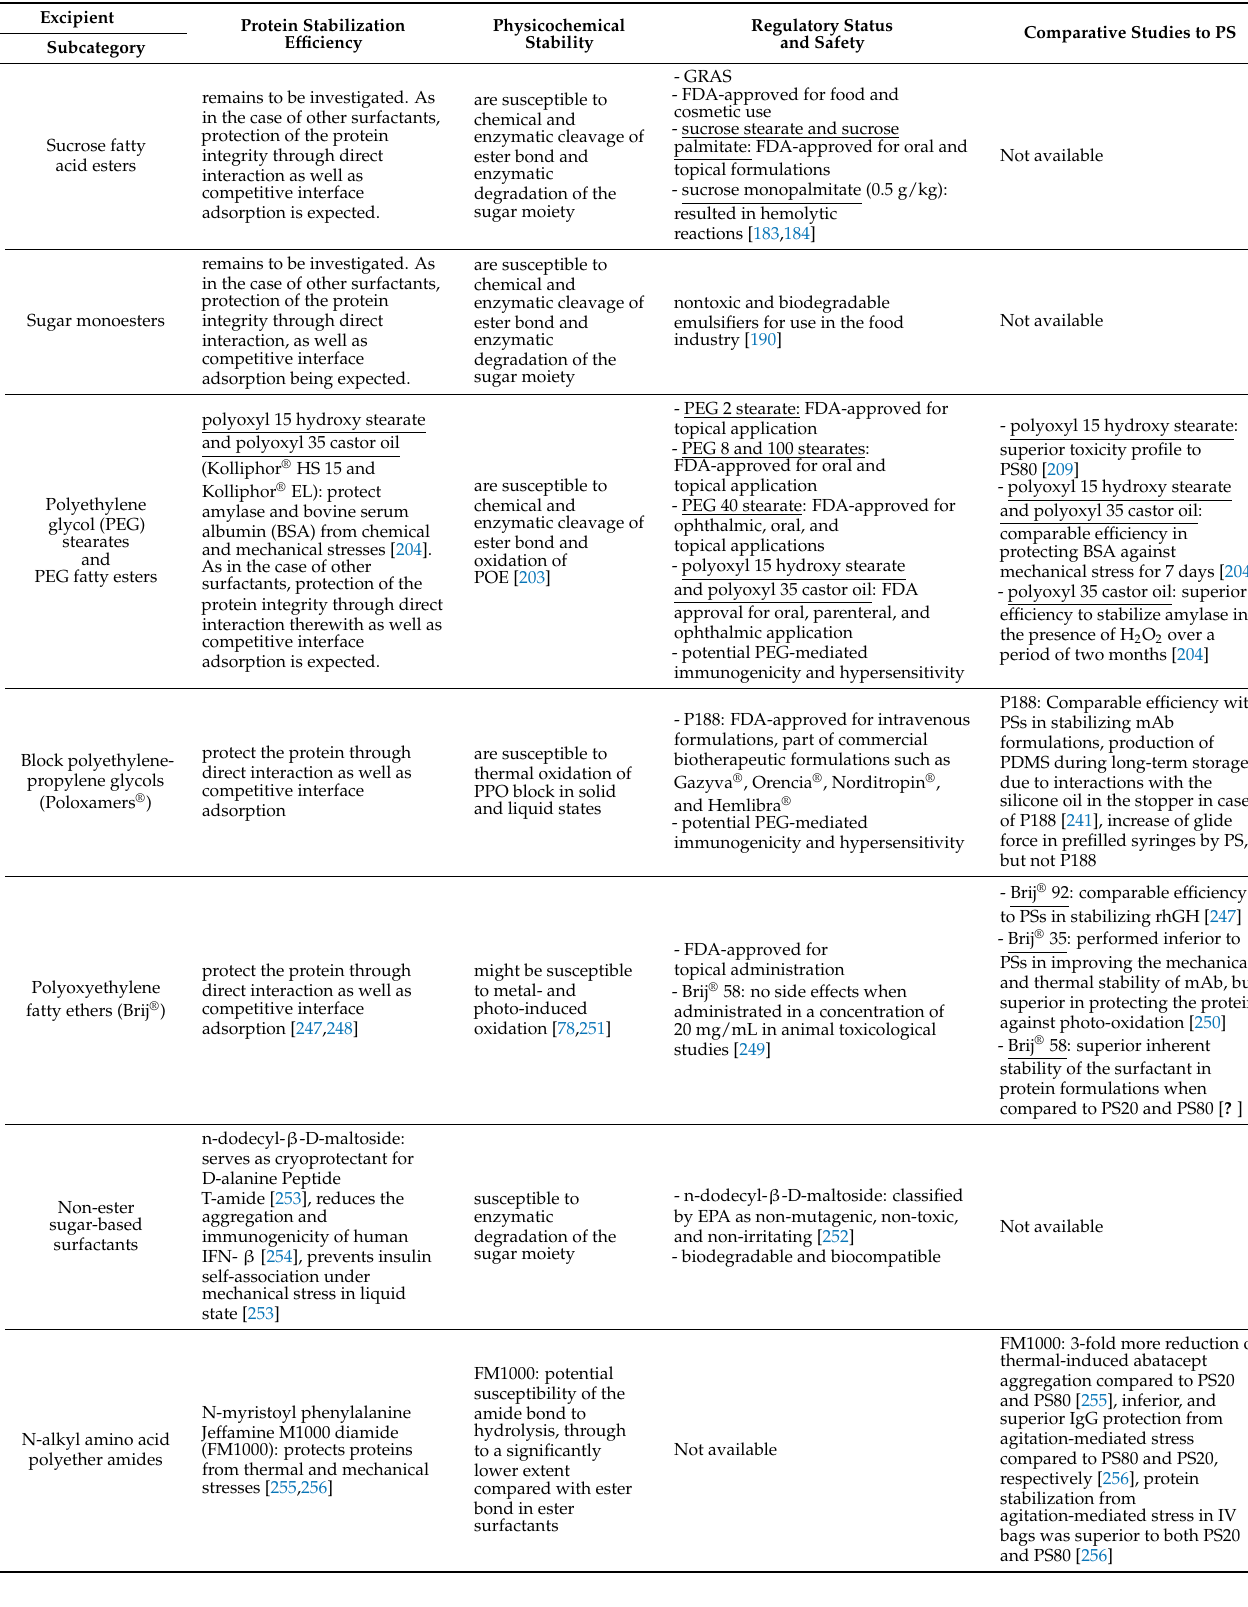
Table 2. Summary of the available information on the potential alternatives to PSs for the stabilization of protein biotherapeutic